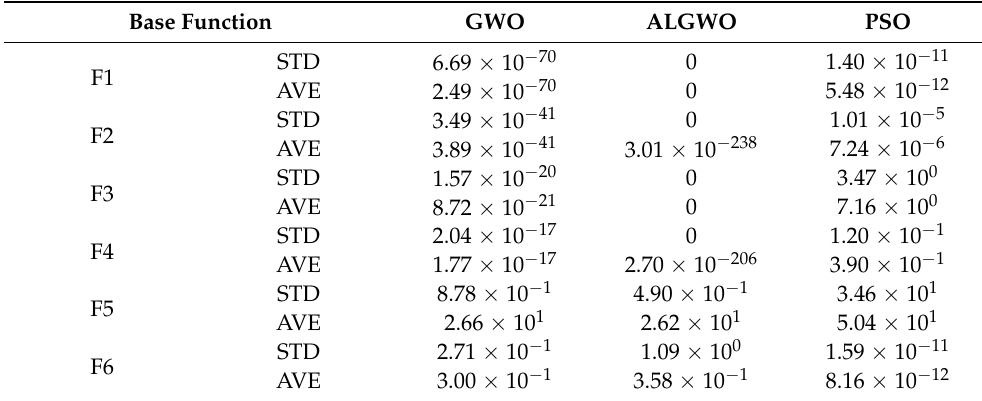
Table 3. Comparison results of three algorithms on six groups of benchmark